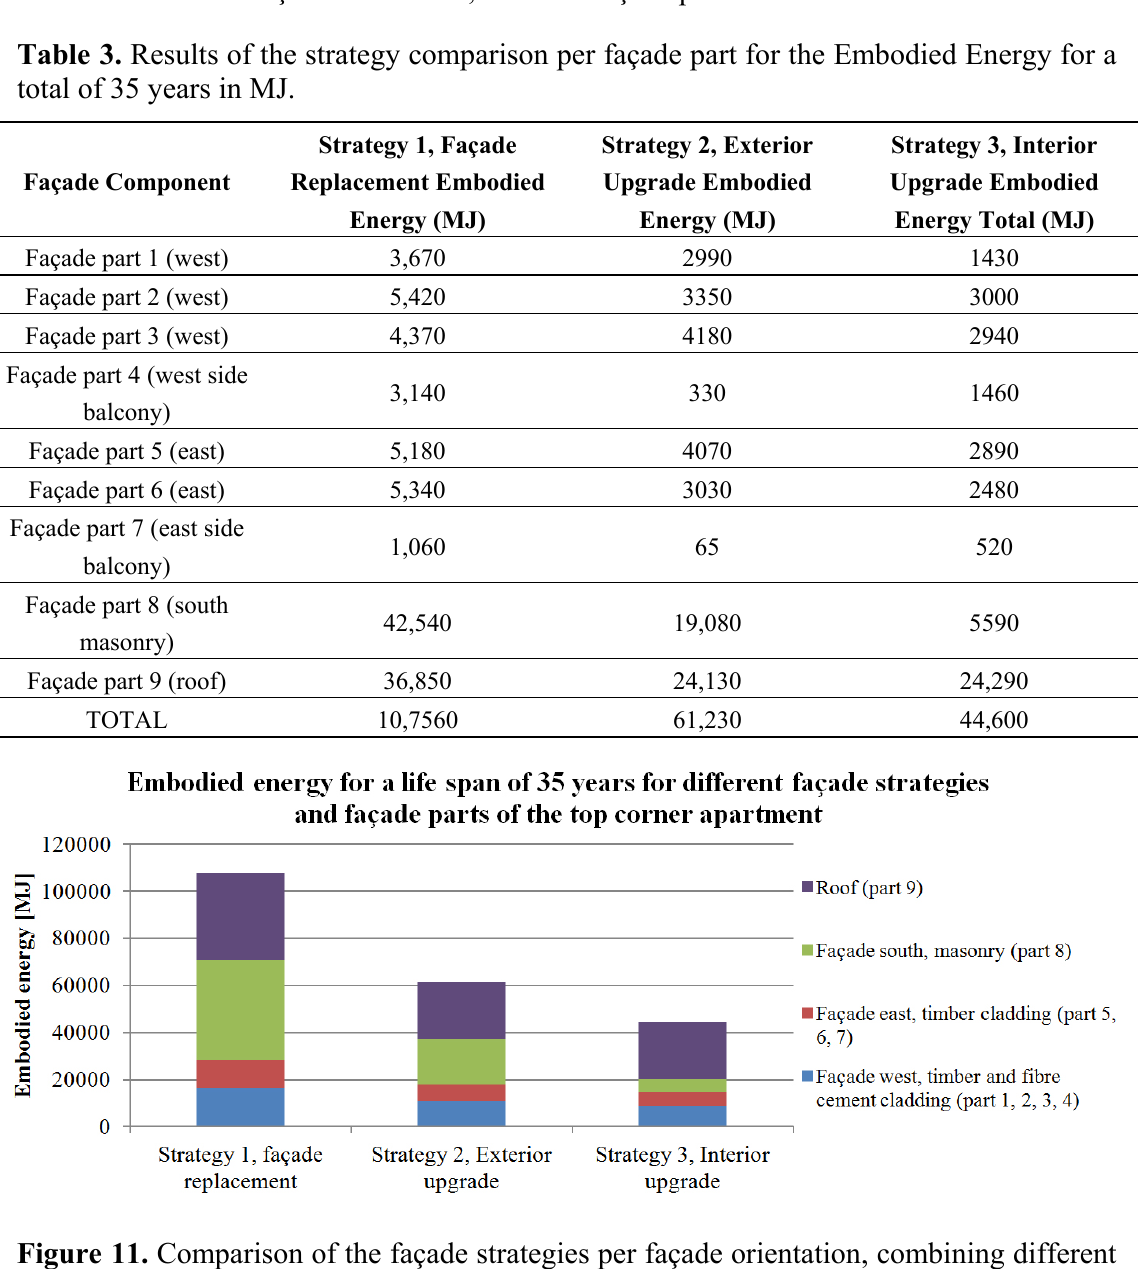
Figure 11. Comparison of the façade strategies per façade orientation, combining different façade parts from the previous table, for the embodied energy for a total lifespan of 35